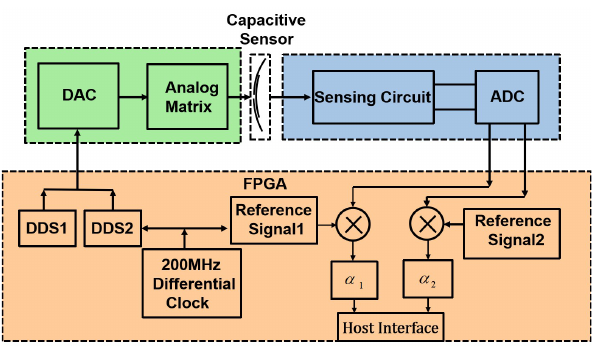
Figure 5. Functional block diagram.